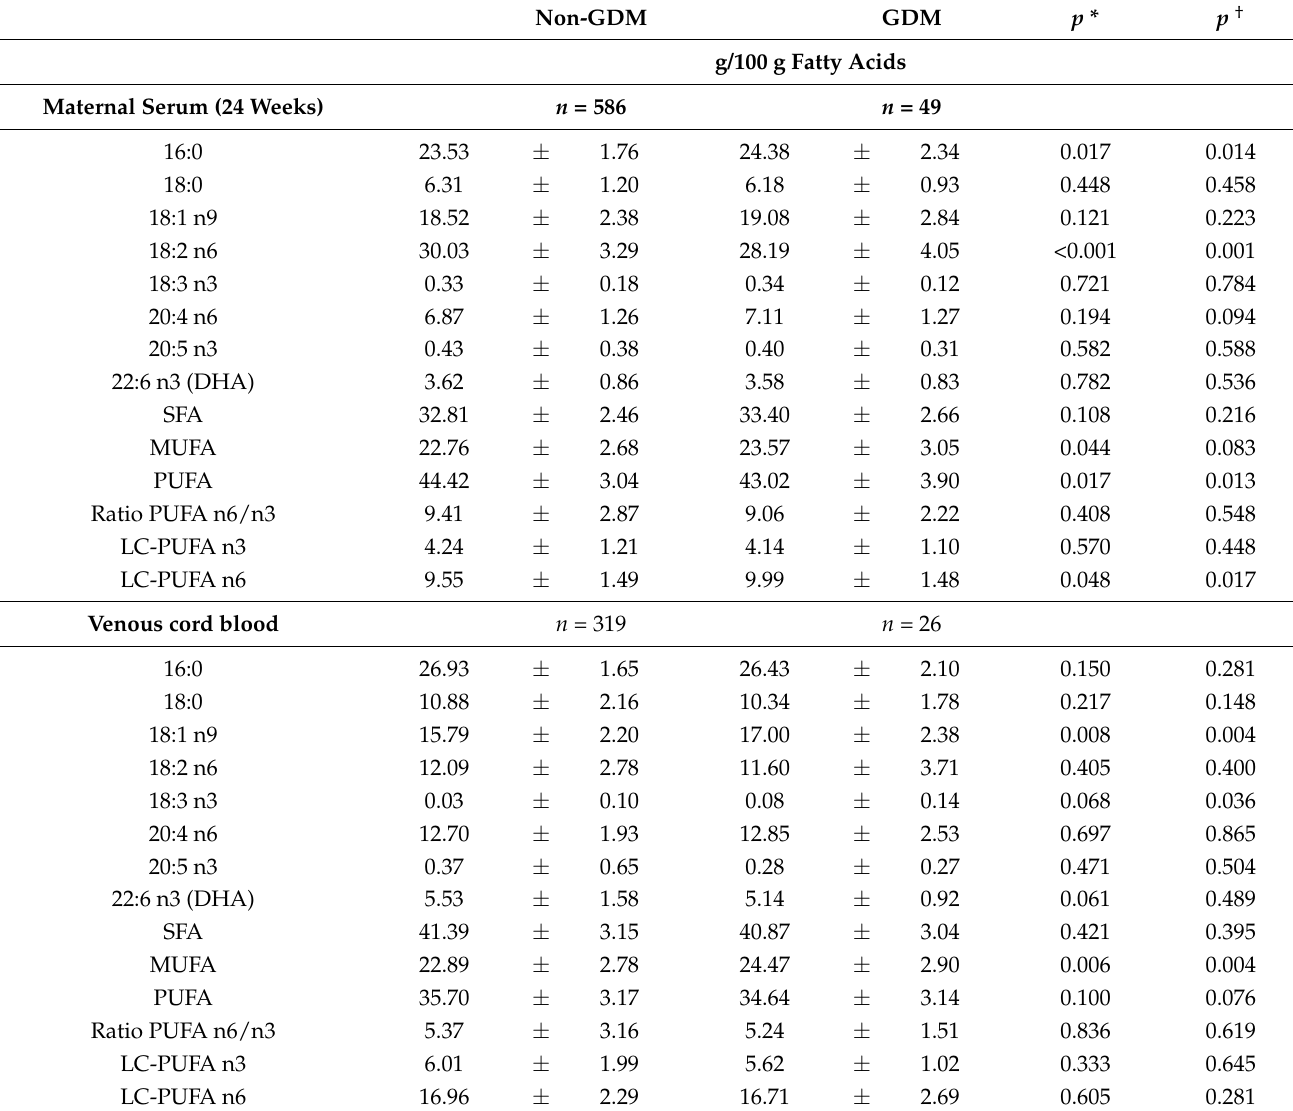
Regarding the results in women with GDM, maternal serum FA profile in both GDM and healthy women presented similar values for DHA percentage at 24 weeks, although PUFAs were lower in women with GDM mainly due to reduced level of LA (Table 5). Newborns from GDM women tended to have lower DHA percentage in cord venous serum compared to those born from non-GDM women ( p = 0.061), although this trend did not remain after adjustment for potential confounders ( p = 0.489) (Table 5). Moreover, higher levels of MUFA were found in cord venous of GDM group as a consequence of higher percentage of oleic acid (18:1 n-9) compared to the non-GDM group. Some minor differences were observed in cord artery FA profile although all of them disappeared after adjustment (Table 5). The arteriovenous difference was similar for all selected FA in both GDM and non-GDM women and hence their offspring tissues FA retention (Table 5). Table 5. Maternal and newborn fatty acid profile in healthy and gestational diabetes mellitus (GDM) pregnancies. The NELA study